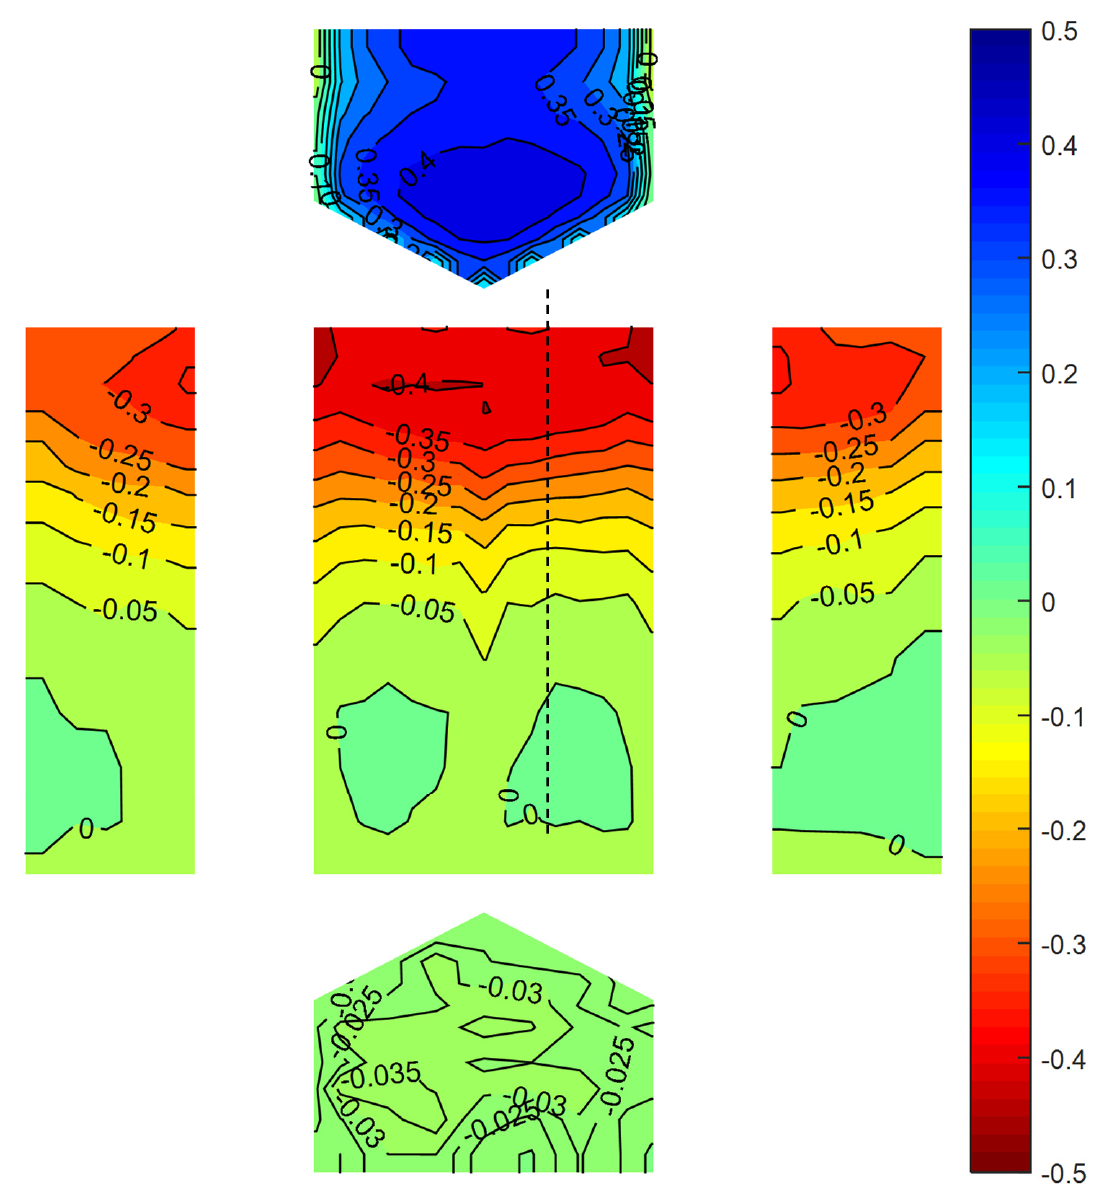
Figure 3. Spatial distribution of mean C p from the wind tunnel tests for wind parallel to ridge for the 12.2-m eave height building. Using the directional procedure, C p is − 0.9 on near the windward edge, − 0.7 on the side wall and 0.8 on the windward wall (ASCE 7–16 Figure 27.3–1). Using the envelope procedure, near the edge, GC p is equal to − 1.07 on the windward roof, − 0.53 on the leeward roof, − 0.48 on the sidewall containing the critical edge zone, − 0.45 on the side wall not containing the critical edge zone, 0.61 on the windward wall containing the critical edge zone, and 0.4 on the windward wall not containing the critical edge zone (ASCE 7–16 Figure